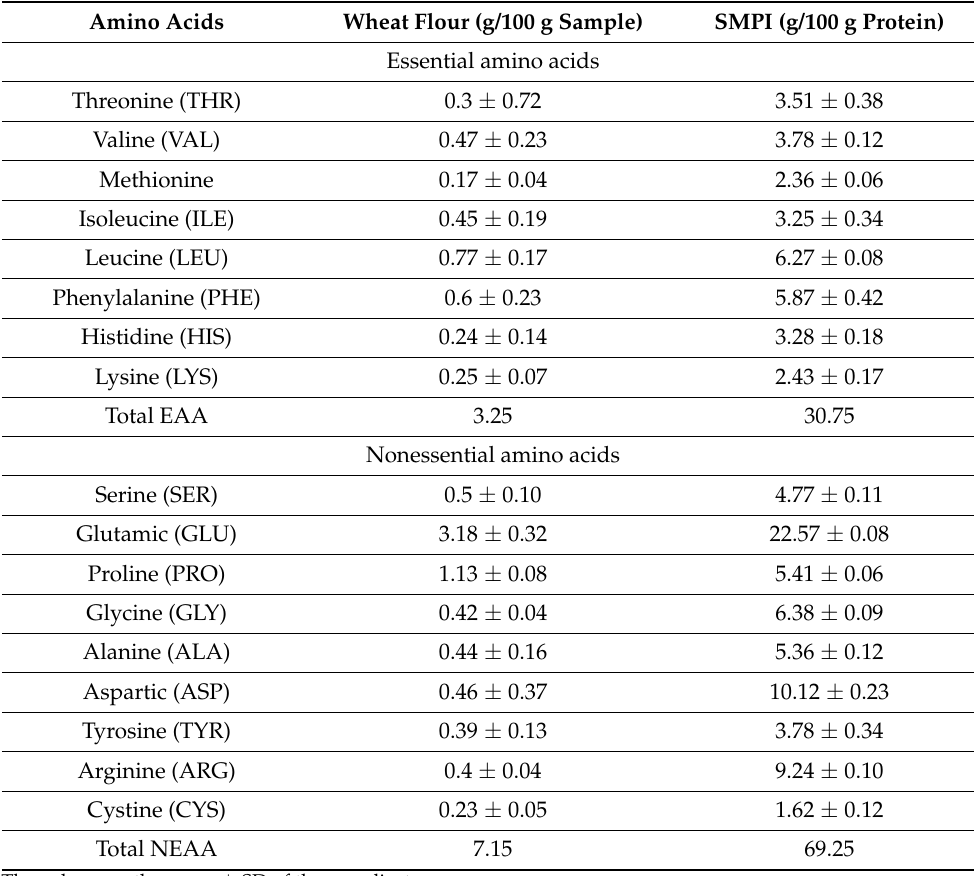
Table 1. Amino acid composition of wheat flour (WF) and SMPI. Amino Acids Wheat Flour (g/100 g Sample) SMPI (g/100 g Protein) Essential amino